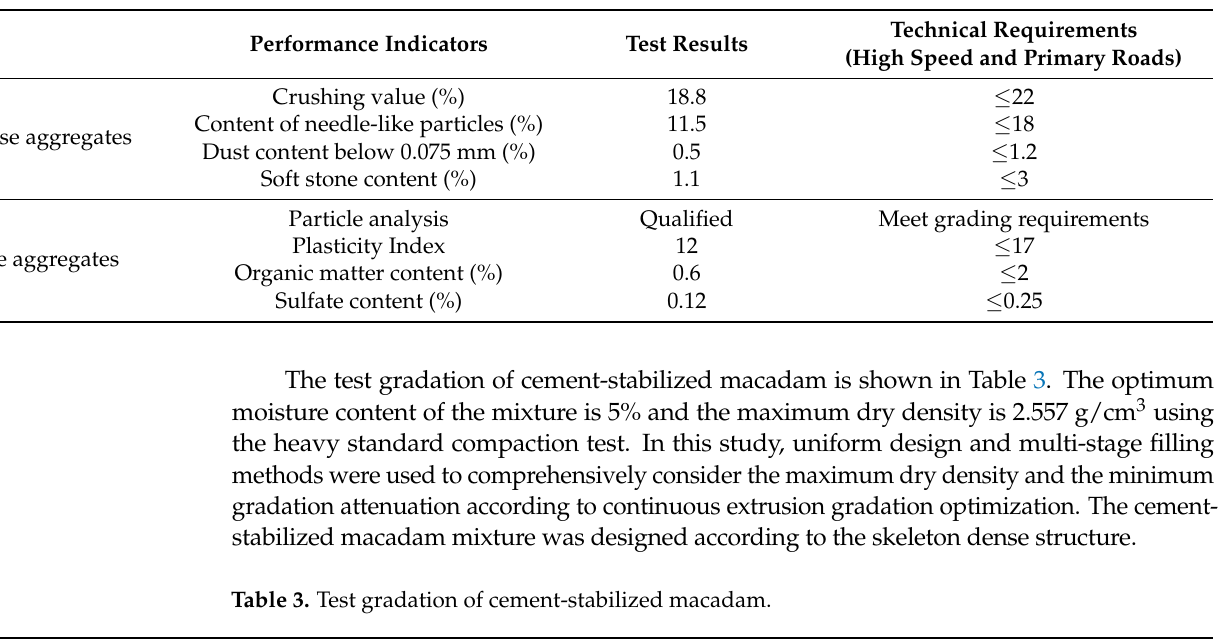
Table 2. Test results of aggregates’ technical indexes.